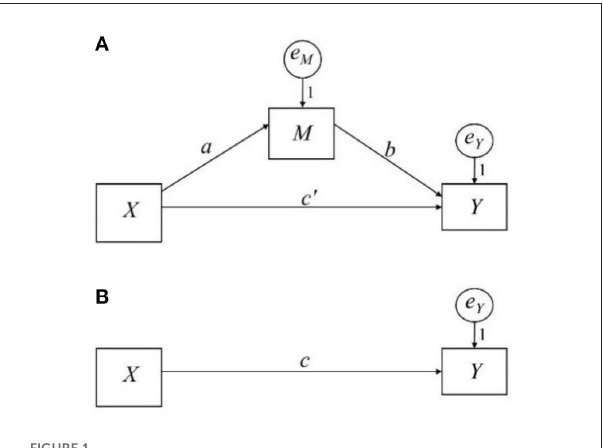
FIGURE1 Path diagram of a simple mediation model and the total effect. (A) Shows the simple mediation model; (B) shows the total effect.